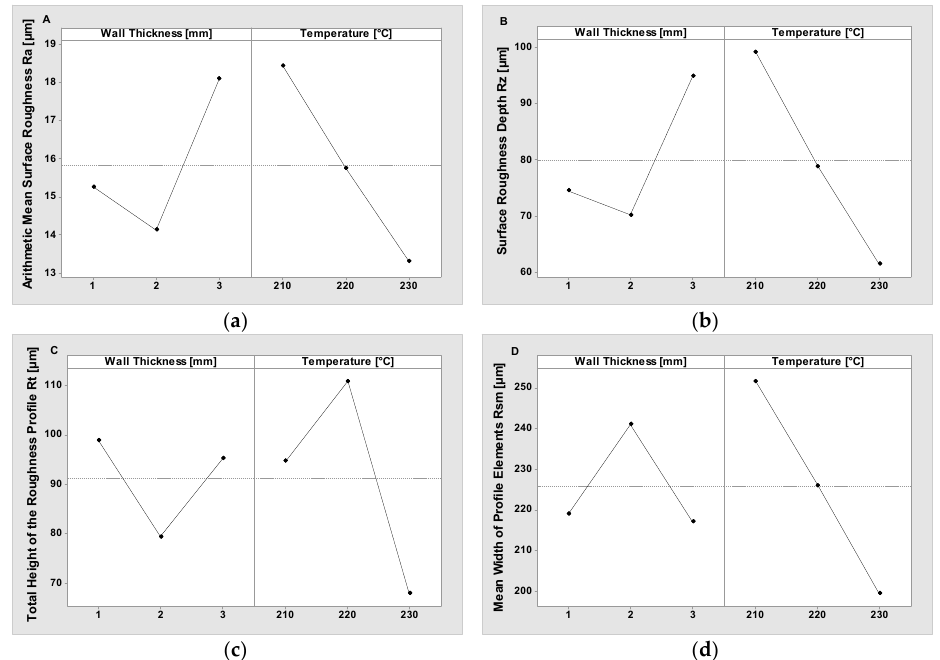
Figure 5. Plot of means for surface roughness parameters: ( a ) arithmetic mean surface roughness Ra, ( b ) surface roughness depth Rz, ( c ) total height of the surface roughness profile Rt, and ( d ) mean width of profile elements Rsm.